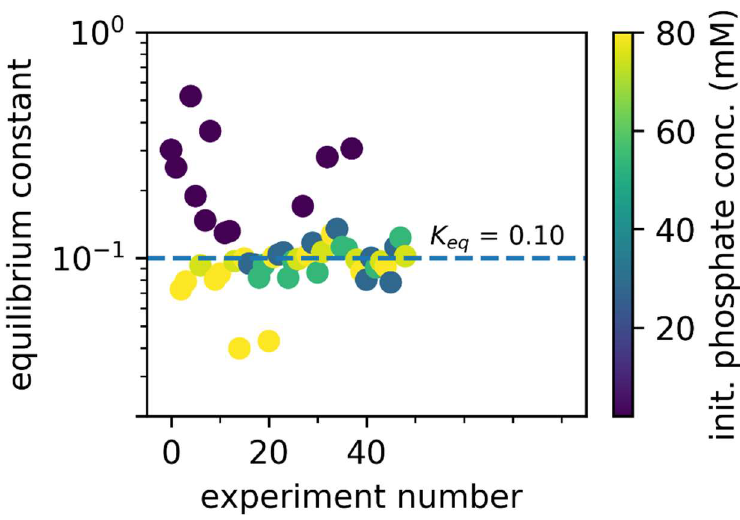
Figure 5. Equilibrium constant determined at different phosphate concentrations. Equilibrium constants of the 48 experiments under varying conditions (see Table S1) as determined from the deoxythymidine/thymine ratios of the 24 h data point as described in Materials and Methods. For concentrations of >2mM phosphate, the experimentally determined values from the 24 h data points are evenly distributed around the value calculated from the parameter estimation (K eq = 0.10). For experiments with lower phosphate concentrations (dark purple circles), the equilibrium constant is significantly off the calculated value from the parameter sets. The median of all experiments is equal to the value calculated from the parameter estimation. Colored circles: K eq calculated from the 24 h data points, purple to yellow: Increasing initial phosphate concentration; blue dashed line: K eq = 0.10, as calculated from the parameter estimation.